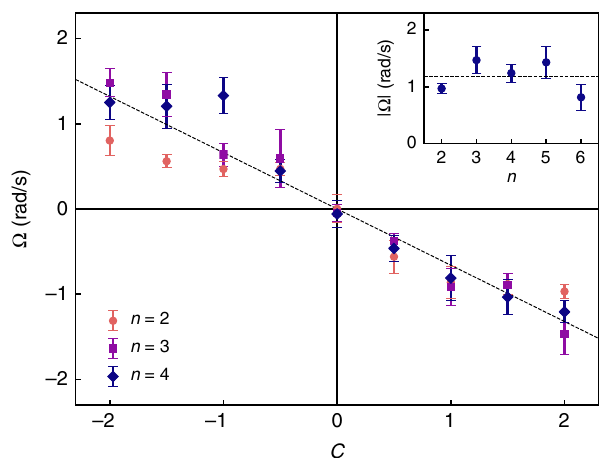
Fig. 2 Effect of shape asymmetry. The angular velocity Ω decreases with increasing shape asymmetry c for particles with different numbers of fi ns n . The inset shows the dependence on n for a constant asymmetry of c = 2. All experiments were performed in 10 wt% hydrogen peroxide. Error bars denote 95% con fi dence intervals for the mean velocity based on the analysis of at least 10 particles (see Methods). Dashed lines are only to guide the